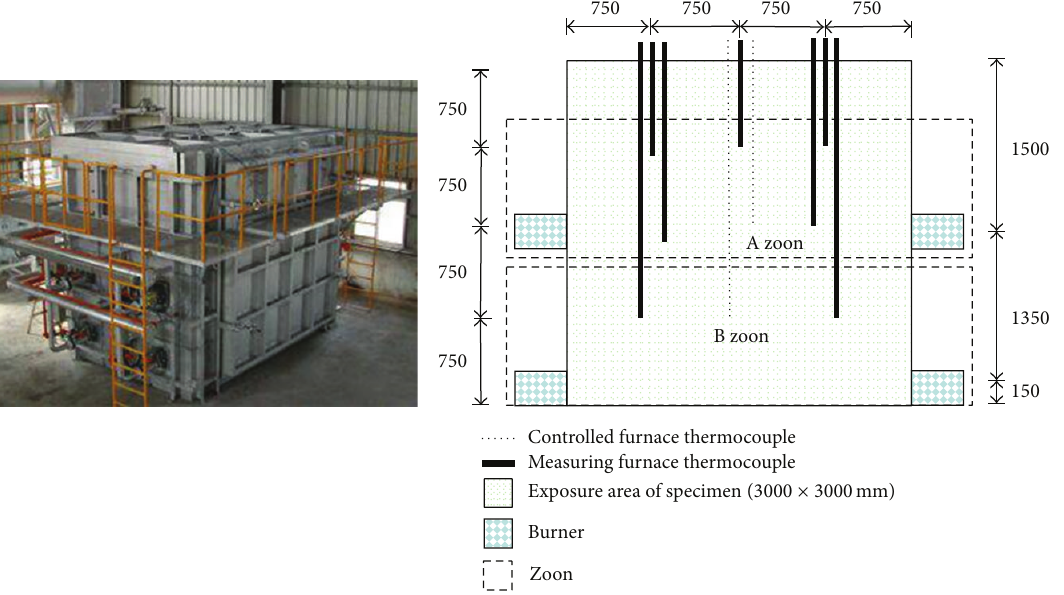
Figure 1: Full-size high-temperature furnace (inner size: 300 cm in width, 300 cm in height, and 240 cm in